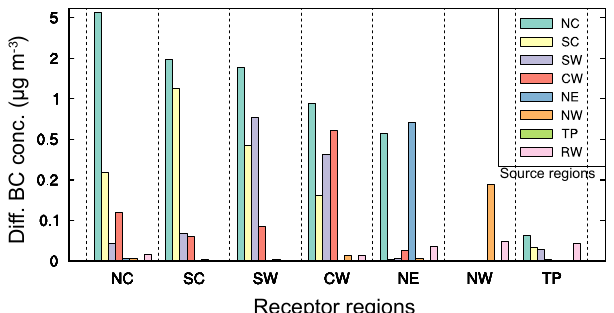
Figure 9. Composite differences in surface BC concentrations (µgm − 3 ) averaged over receptor regions (marked on the horizontal axis) over eastern and central China between polluted and normal days in DJF originating from individual source regions (bars in each